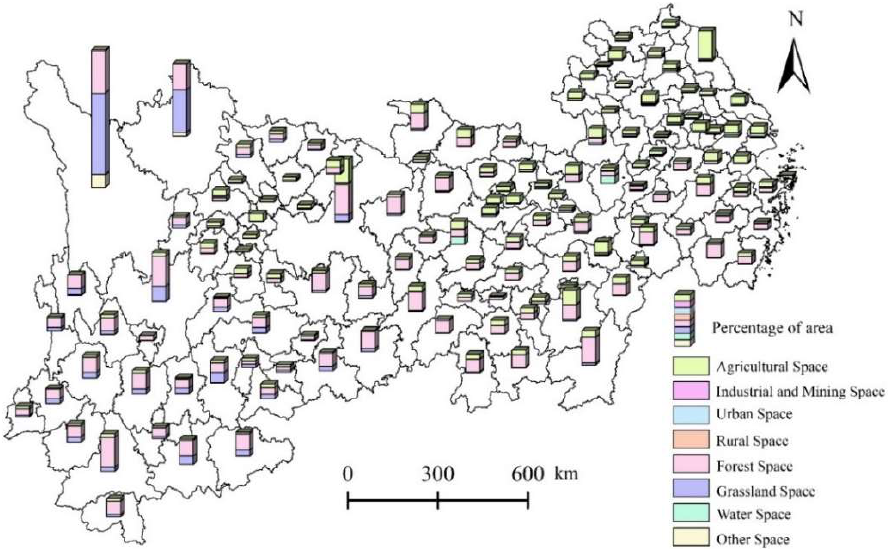
Figure 9. Distribution of territorial space in the Yangtze River Economic Belt. The distribution and evolution of living space are positively correlated with production space. The urban space is distributed in the Yangtze River Delta, the urban agglomeration is concentrated in the middle reaches, and the capital cities are located in the upper reaches, all of which are areas with a high level of urbanization. The rural space is distributed in the areas with more agricultural space, primarily because these areas are suitable for agricultural production and have a better natural environment, flatter terrain, and more concentrated population, which has formed the agglomeration area of these rural settle- ments. The regional differences in living space changes have been small, and most of the regions are predominantly expansionary. In particular, the urban space has shown a generally dense expansion throughout the whole region, which may be driven by a new type of urbanization policy and may be related to the expansion of industrial and mining space, where industries tend to be distributed around the cities, and the development of these industries drives the construction of towns to a certain extent. Rural spaces often are built along mountains and rivers, and this type of expansion has been relatively obvious in the middle and lower reaches, where the terrain is relatively flat and the lakes and river networks are